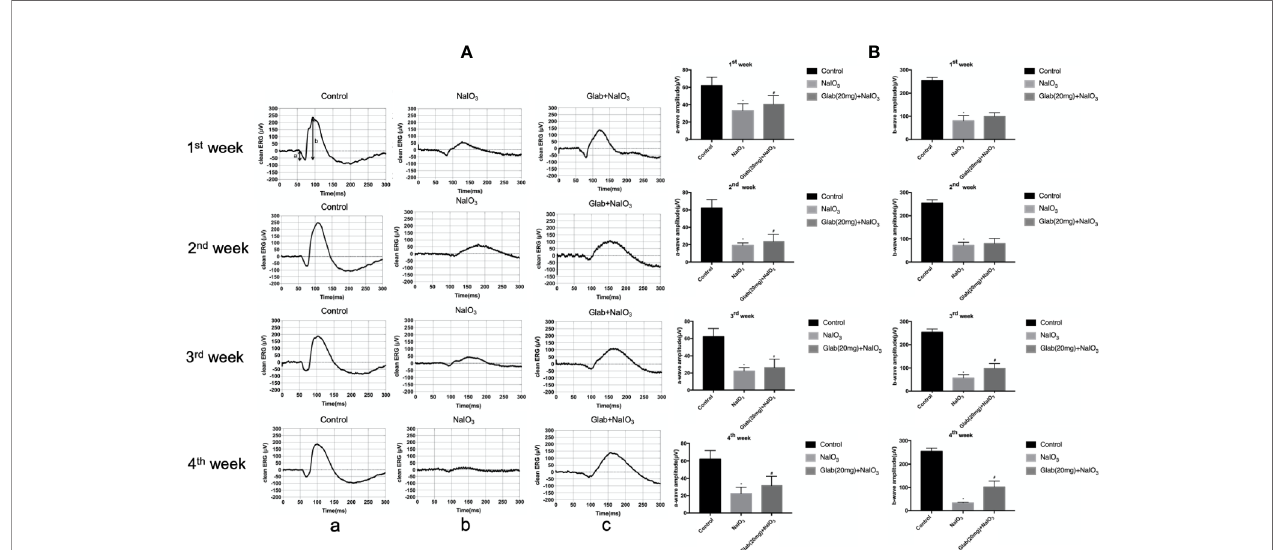
FIGURE 4 | Effects of Glabridin on the retinal function after sodium iodate (NaIO 3 ) treatment in vivo . (A) Electroretinography (ERG) images of changes in the retinal function of mice within four weeks after NaIO 3 injection and Glab treatment. a, retina of normal mice (Control); b, retina treated with NaIO 3 (25mg/kg) (NaIO 3 ); c, retina treated with Glabridin(20mg/kg) plus NaIO 3 (Glab+NaIO 3 ). The degeneration of retinal function in the retina of mice treated with NaIO 3 was signi fi cantly seen throughout 4 weeks. The amplitudes of the waves in the Glab+NaIO 3 treatment group were signi fi cantly higher than those in the NaIO 3 group throughout 4 weeks suggesting that the retinal function in the retinas of mice treated with Glab was protected from retinal damage induced by NaIO 3 . (B) From the fi rst week to the fourth week, the amplitudes of a-wave and b-wave in both the NaIO 3 group and Glab+NaIO 3 group were signi fi cantly lower than those in the control group (* P < 0.05). The amplitudes of both a-wave and b ‐ wave in the Glab+ NaIO 3 group were signi fi cantly higher than those in the NaIO 3 group ( # P <